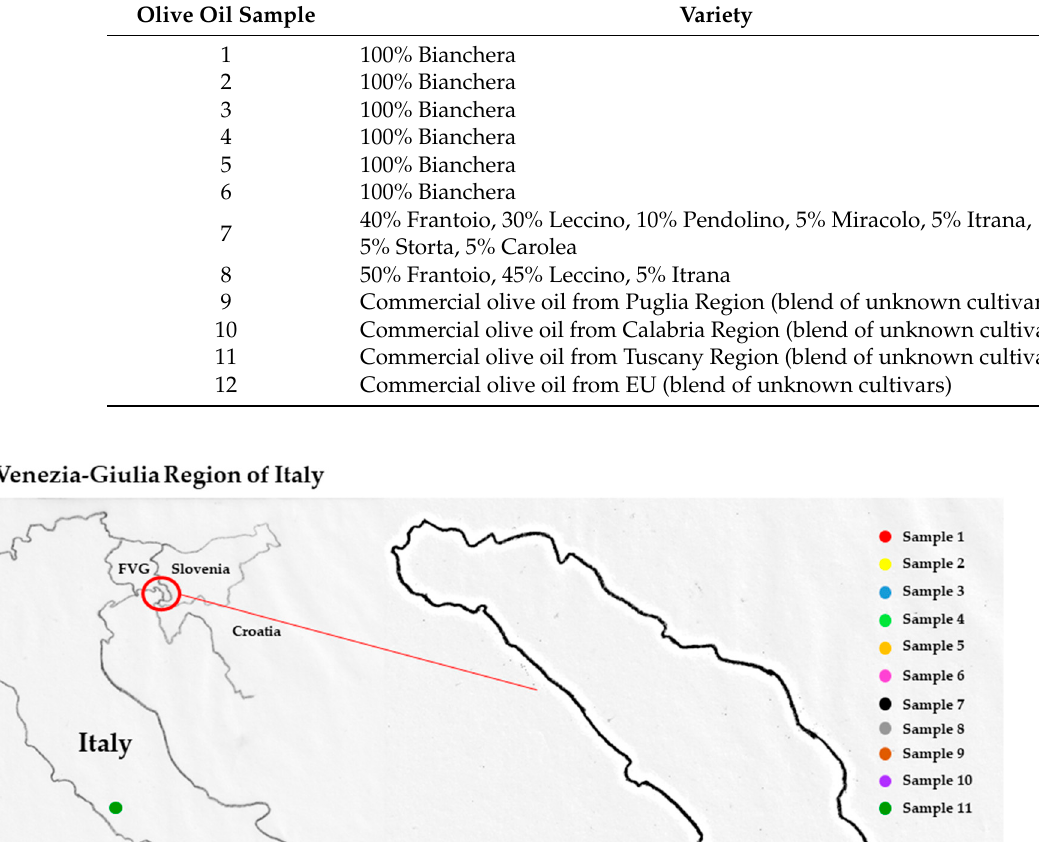
Table 3. Olive oil samples.